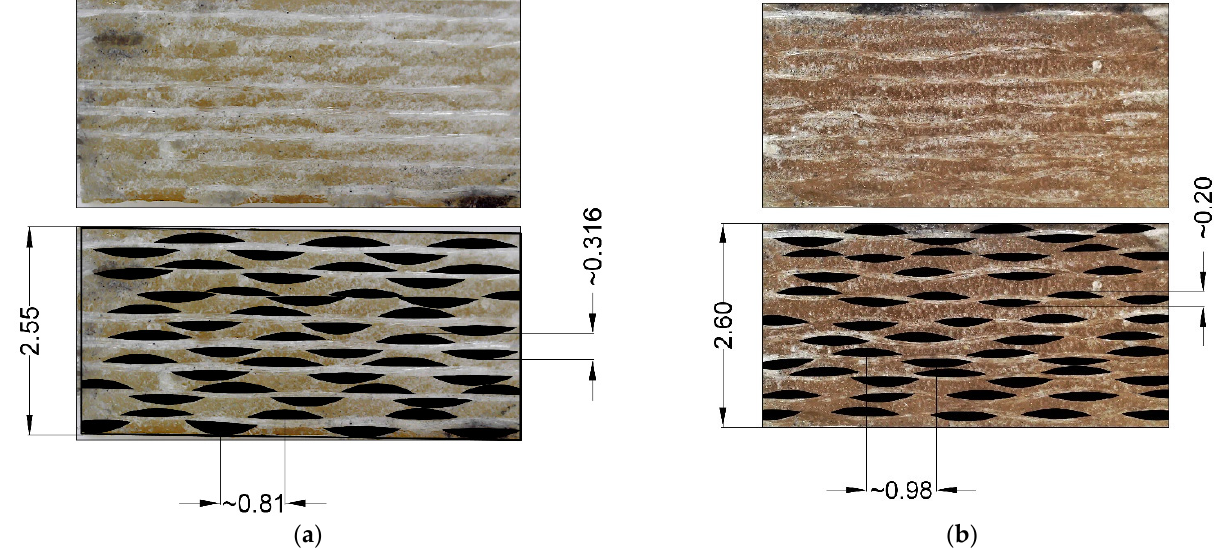
Figure 4. Microphotographs of the structure of fiberglass samples: ( a ) T-23; ( b ) EZ-200.